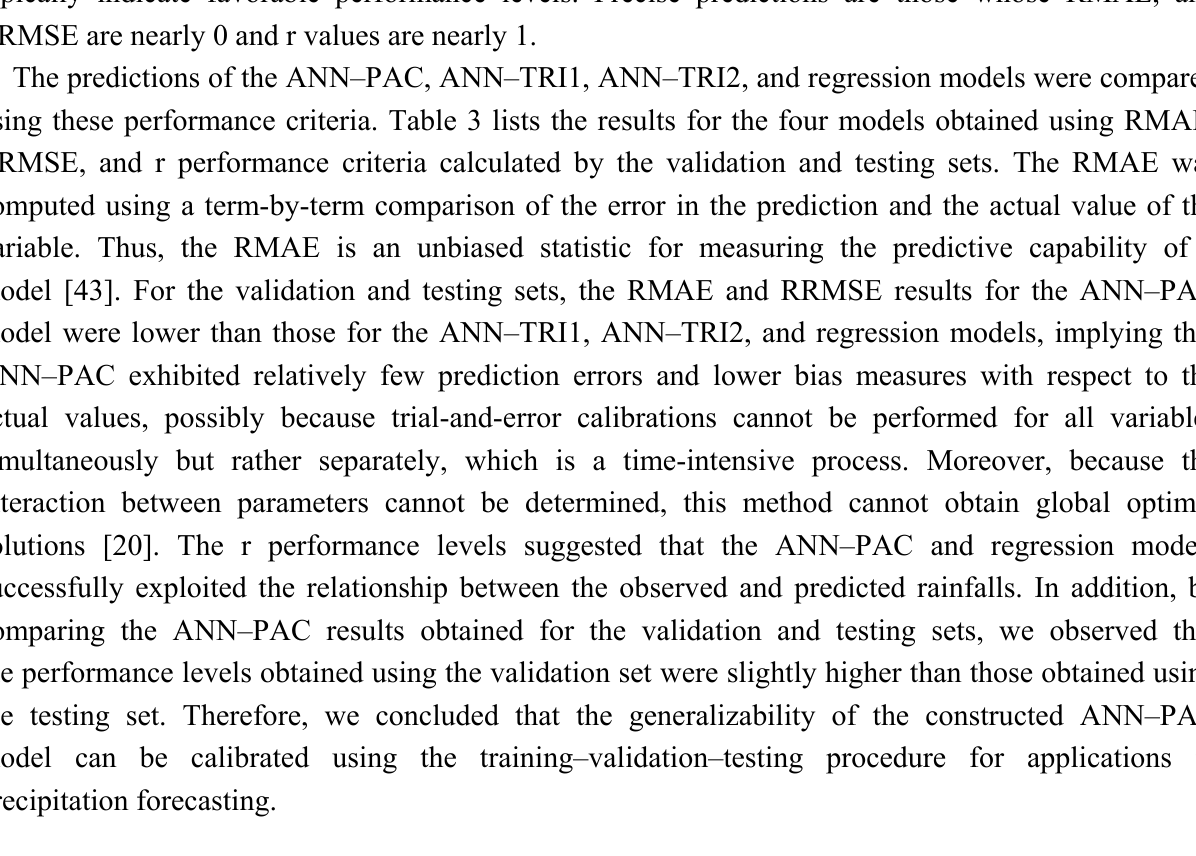
Table 3. Performance levels of the various models assessed by using the validation set Testing